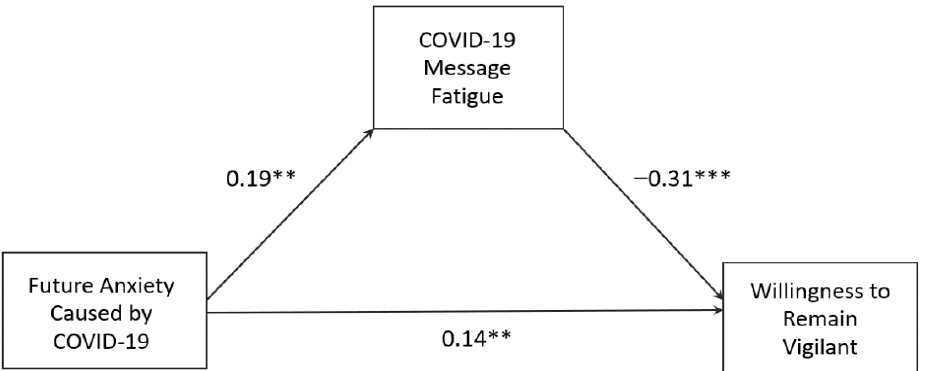
Figure 3. The mediation model predicting willingness to remain vigilant. The paths show unstan- dardized coefficients. ** p < 0.01. *** p < 0.001.